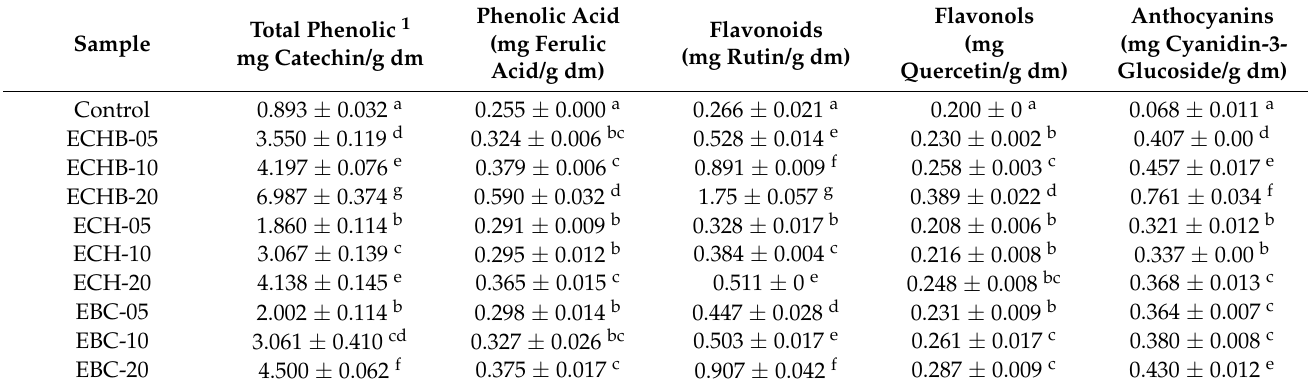
Table 4. Selected phenolic compounds and flavonoids content in corn extrudates with addition of fruit